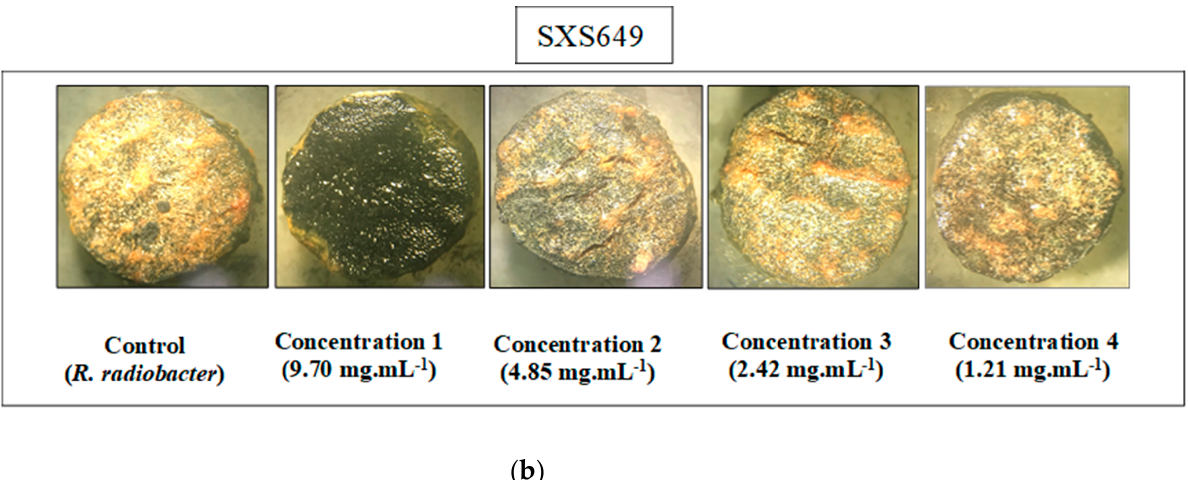
Figure 4. Antitumor activity in potato discs of extracts of the endophytic fungi Colletotrichum sp. SXS649, Pestalotiopsis sp. SXS650, Botryosphaeriales SXS651, and Diaporthe sp. SXS652 isolates from P. rigida Kunth. ( a ) Inhibition rate against the concentration of fungal extracts. Values correspond to the average of 3 repetitions; and ( b ) Potato disc tumors treated with Colletotrichum sp. SXS649.